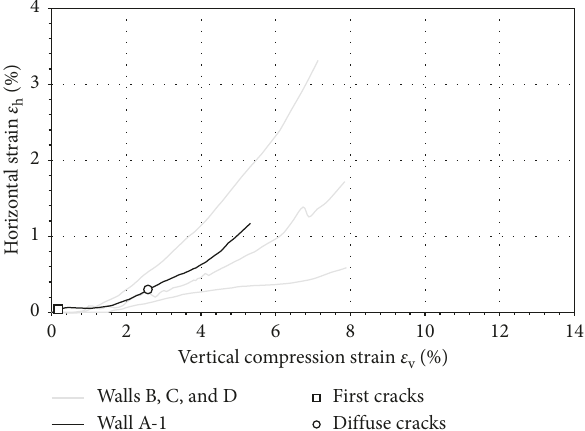
Figure 10: Horizontal strain-vertical strain diagrams for the specimen tested at about 0.025MPa/min (Wall A) and comparison with other tested specimens (0.077MPa/min). The reported vertical and horizontal strains are computed by averaging the displace- ments measured by the two vertical and horizontal LVDTs, re- spectively. Post-peak behaviour (dotted lines) can be considered as completely reliable since test was force